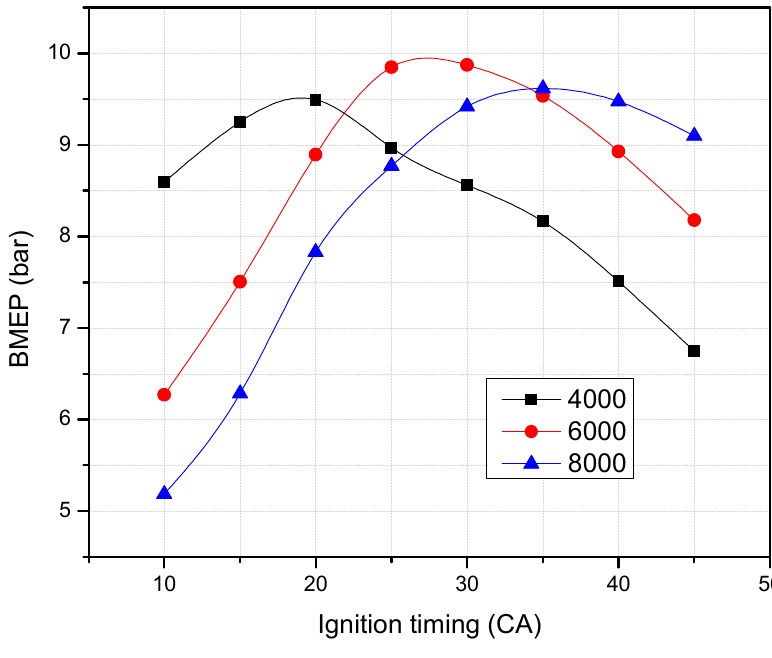
Figure 13. BMEP versus ignition timing.